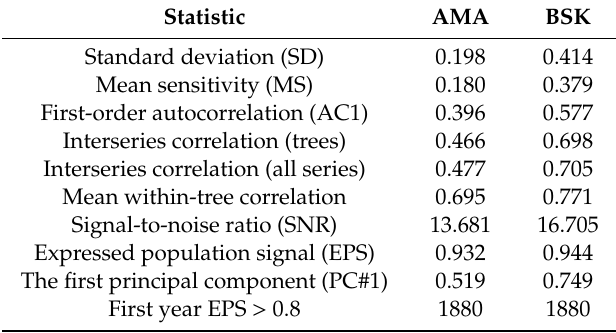
Table 2. Statistical characteristics of the two tree-ring chronologies for the common period